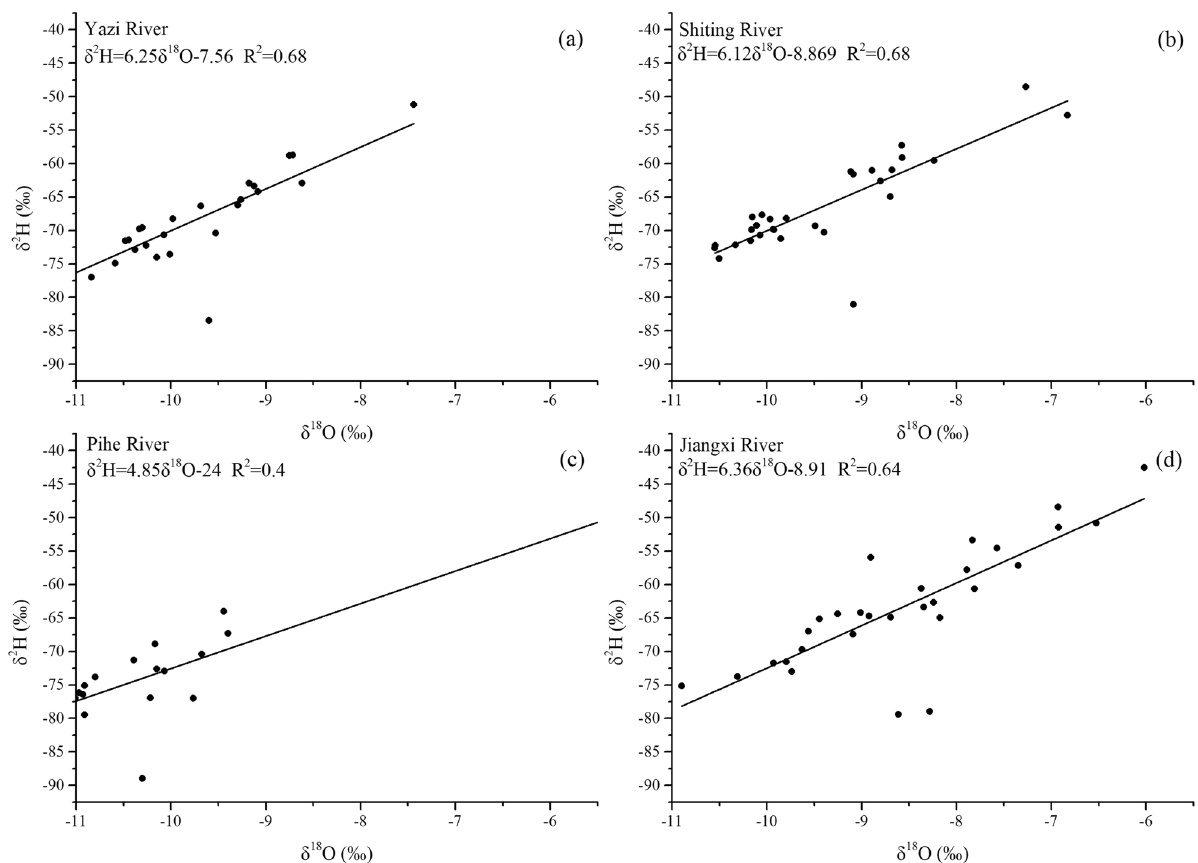
Figure 3. RWL of four tributaries of the Tuojiang River (Yazi River ( a ), Shiting River ( b ), Pihe River ( c ), Jiangxi River ( d